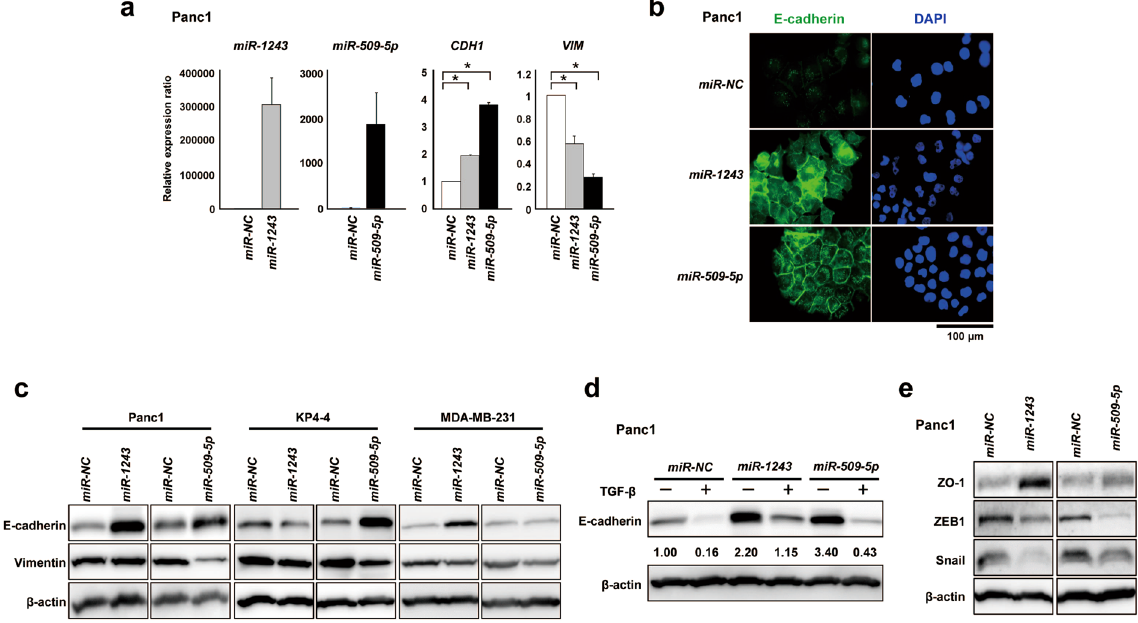
Figure 2. miR-509-5p and miR-1243 induce an MET phenotype in several cancer cell lines. ( a ) The expression of miR-509-5p , miR-1243 and EMT marker genes was confirmed by qRT-PCR in Panc1 cells 72 hours after transfection of miR-509-5p and miR-1243 ; the data are the mean ± SD (bars) for duplicate experiments. ( b ) Immunofluorescent staining of E-cadherin (green) and DAPI (blue) in Panc1 cells after transfection of 10 nmol/L of miR-NC , miR-509-5p or miR-1243 . ( c ) Western blot analysis of E-cadherin and Vimentin protein levels in Panc1, KP4-4 and MDA-MB-231 cells 72 hours after transfection of 10 nmol/L of miR-NC , miR-509-5p or miR-1243 . ( d ) The expression of E-cadherin in Panc1 cells 72 hours after treatment with or without TGF- β (5 ng/ml) and simultaneous transfection with miR-NC , miR-509-5p and miR-1243 . The number under the figure indicates the relative ratio based on the miR-NC expression level. ( e ) Western blot analysis of the EMT-related proteins ZO-1, ZEB1 and Snail in Panc1 cells 72 hours after transient transfection with 10 nmol/L of miR-NC , miR-509-5p and miR-1243 . Student’s t -test was used for statistical analysis, and asterisks represent P < 0.05 versus miR-NC